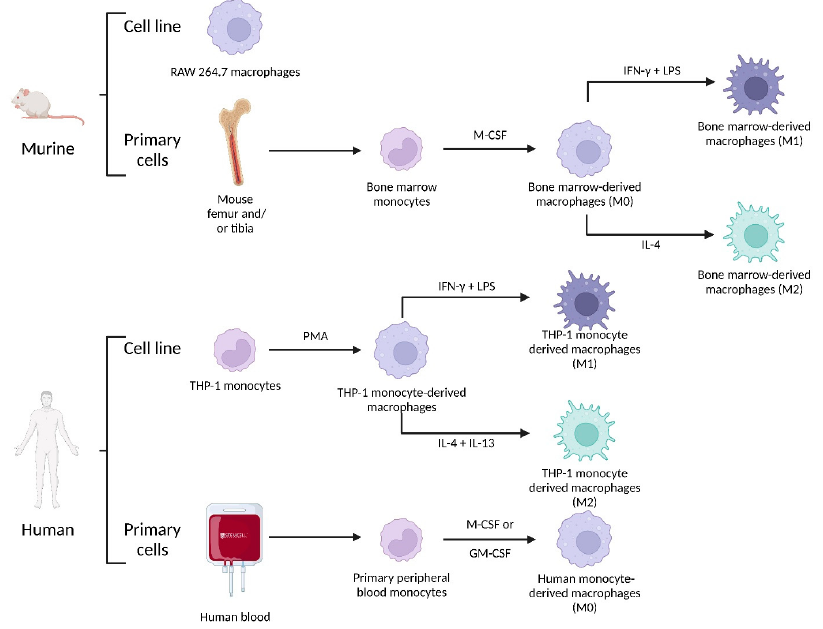
Figure 4. Some of the in vitro models based on murine or human macrophages. Created with BioRender.com.